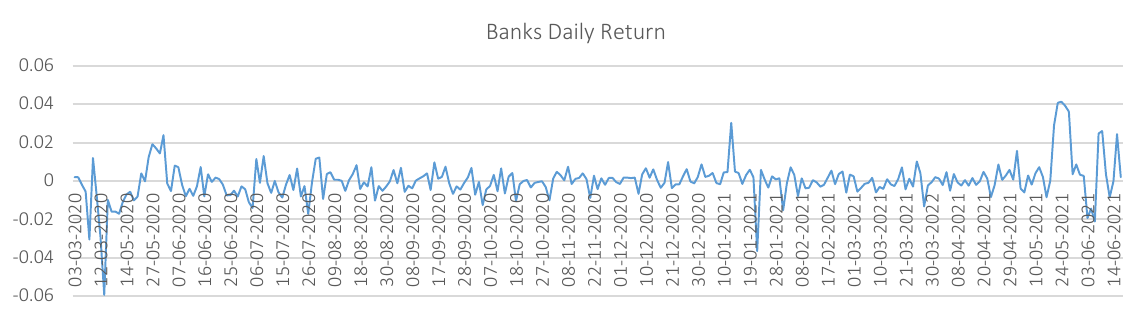
Figure 1. ASE index during the pandemic